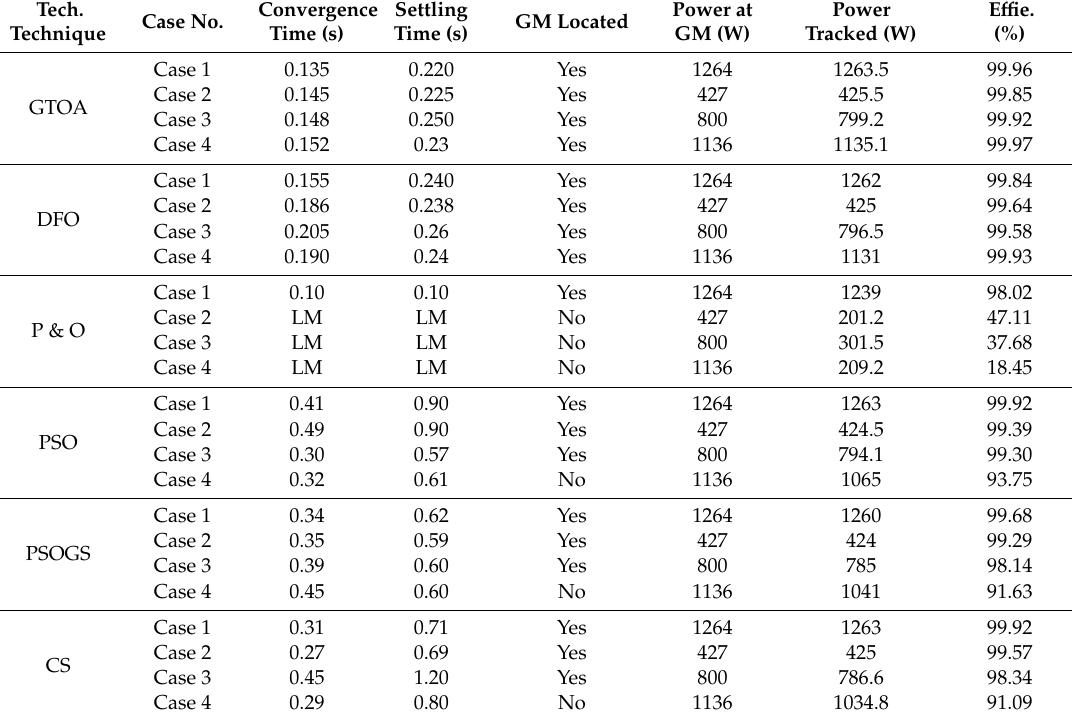
Table 4. Quantitative analysis of GTOA with dragon fly optimization (DFO), particle swarm optimization (PSO), perturb and observe (P&O), cuckoo search (CS), and particle swarm optimization gravitational search